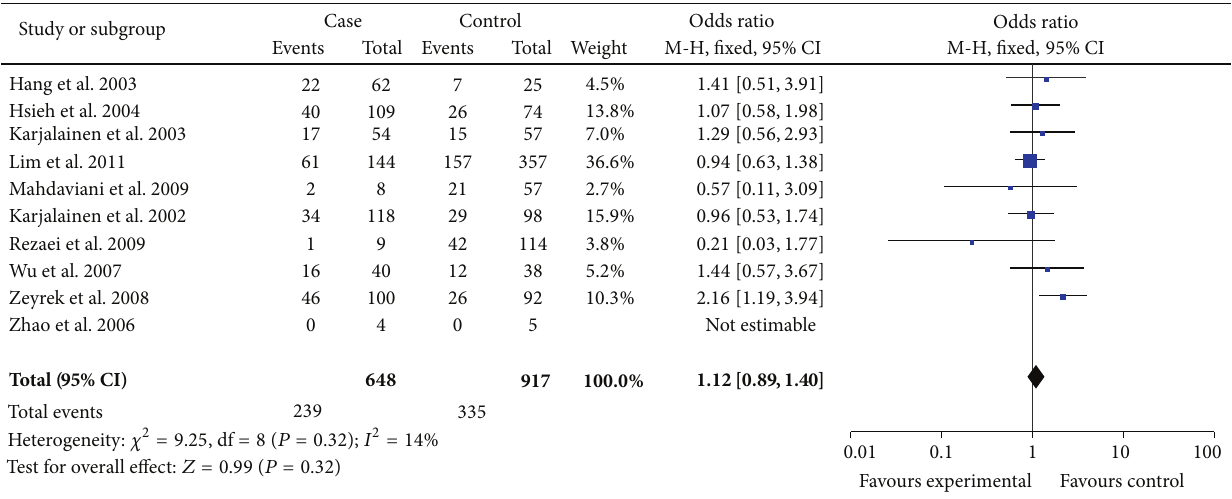
Figure 2: Forest plot the IL-1 𝛽 -511C/T polymorphism and asthma risk (CC verses